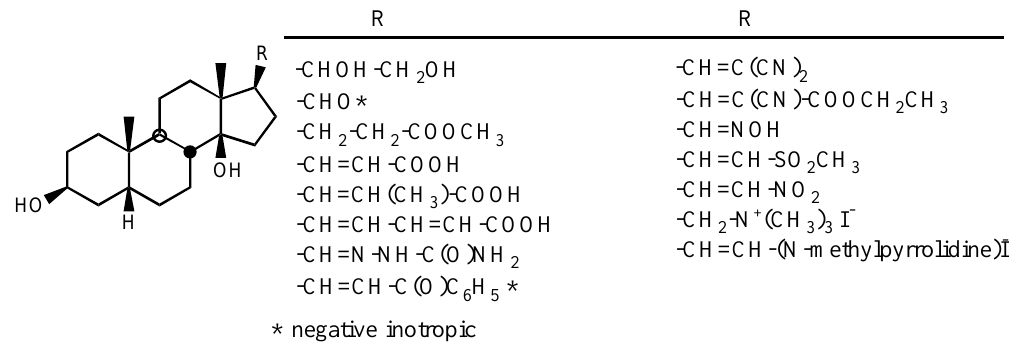
Figure 13. Structure of some inactive semisynthetic digitalis-like derivatives, substituted at C17 b